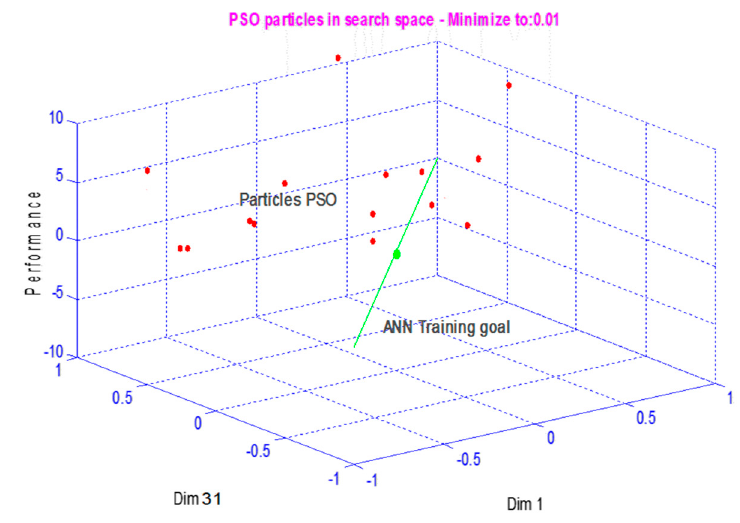
Figure 7. Particles of PSO in the search space.